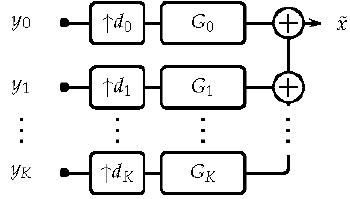
Figure 2. General structure of a non-uniform synthesis FB ( G k , d k ) k , also denoted by (cid:101) S ( · , ( G k , d k ) k ) .